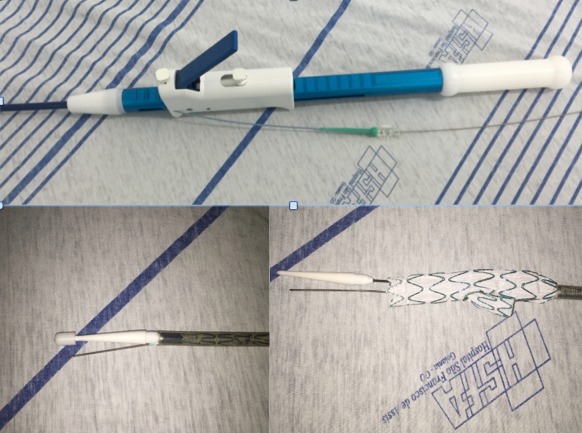
Bench set up of customized endoprosthesis with iliac branch and pre-catheterization system for deployment in ex vivo test.